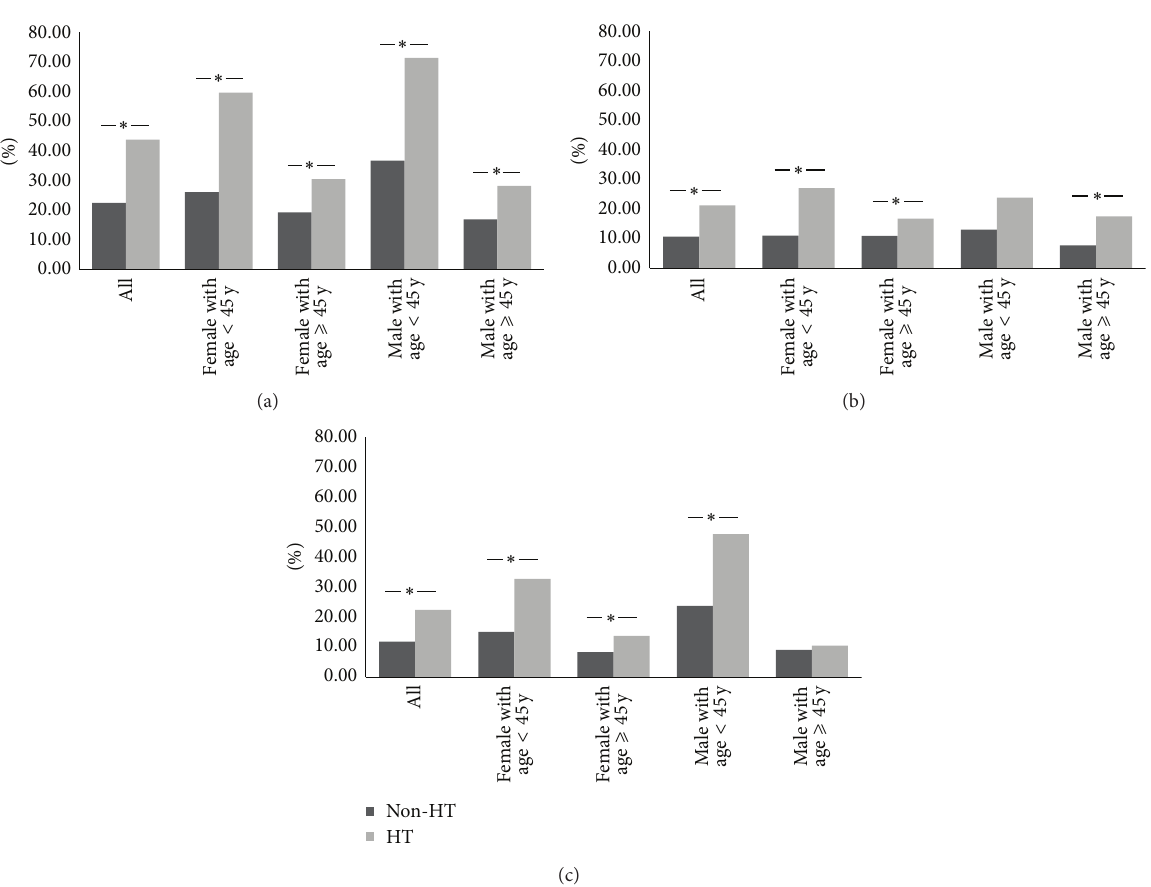
Figure 1: The prevalence of PTC (a), mPTC (b), and crPTC (c) in different age and gender groups. ∗ 𝑃 < 0.05 .